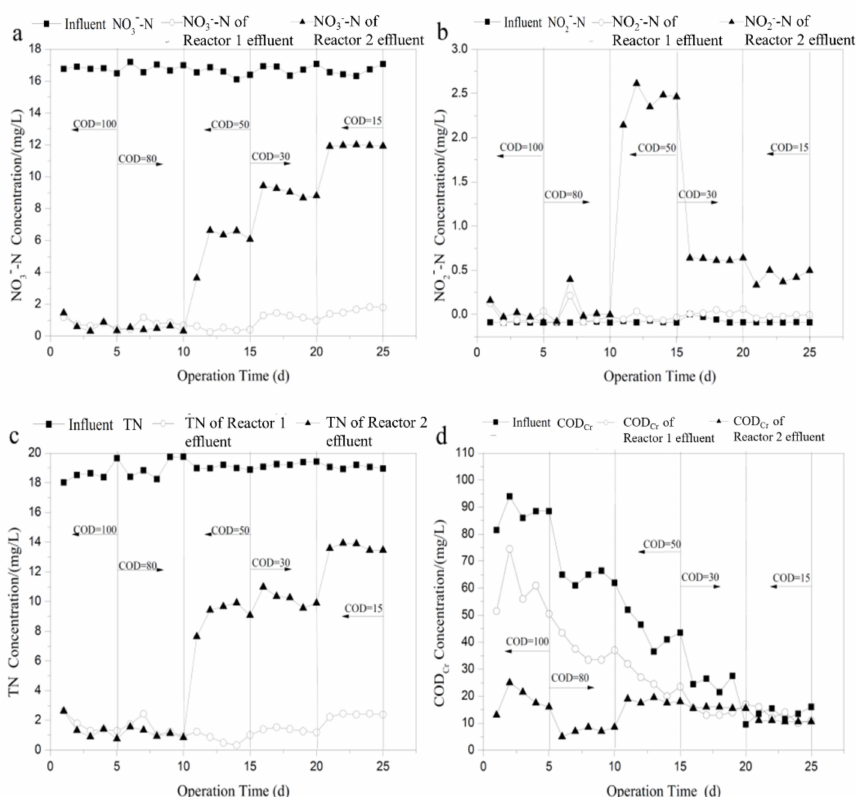
Figure 6. Influence of C / N ratio on e ffl uent: ( a ) nitrate; ( b ) nitrite; ( c ) TN; and ( d ) COD Cr concentration of the two